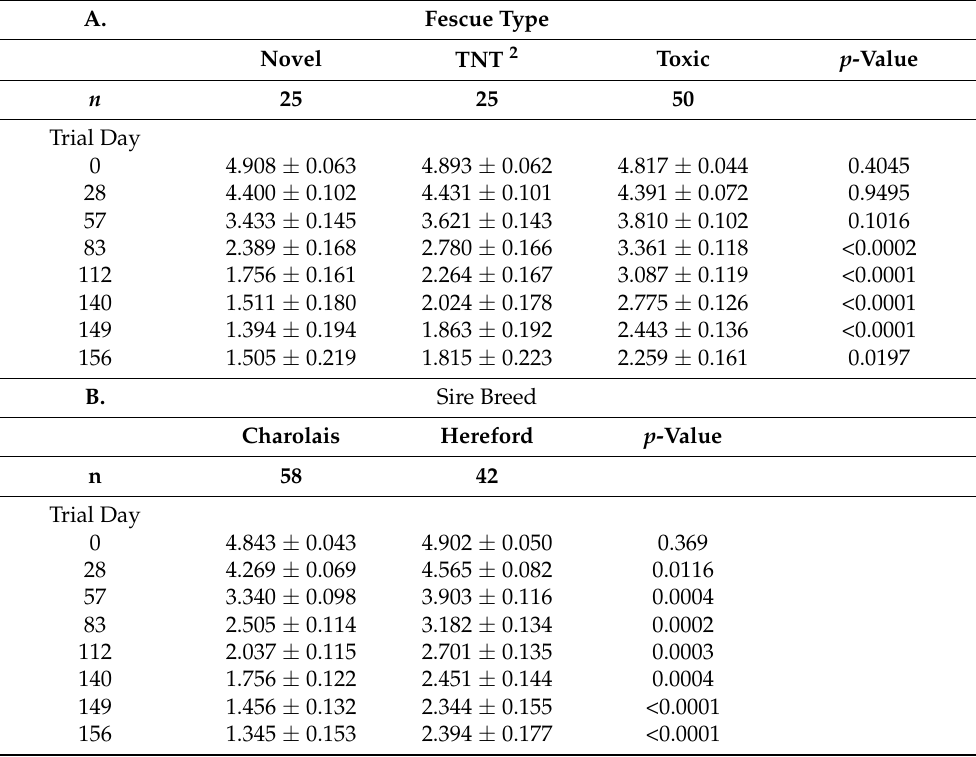
Table 3. Fescue type and sire breed effects for hair coat score (HCS) 1 . (A) Least square means ± standard error for HCS by date of measurement by fescue exposure. ( B ) Least square means ±